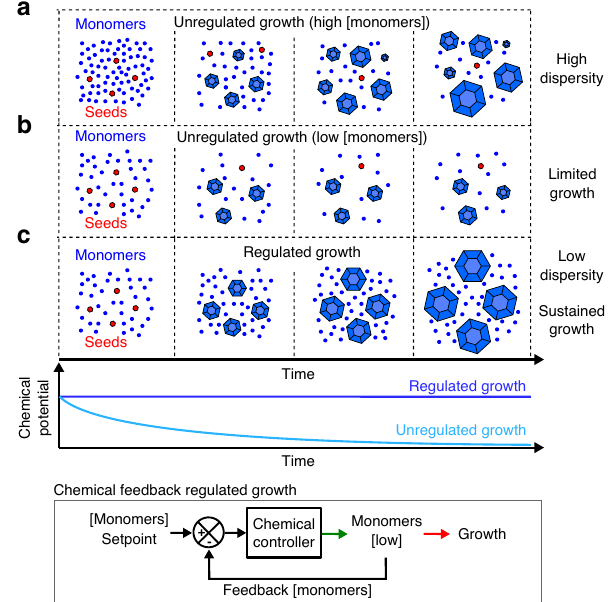
Fig. 1 Crystal size, size dispersity, and quality are shaped by growth conditions, such as the initial monomer concentration and how fast monomers are depleted during crystallization. Schematics show 3D crystals (blue) growing in the presence of seeds (red). a Far above the critical monomer concentration, new crystals homogeneously nucleate (i.e., not from seeds) continuously while other crystals grow. As a result, the crystals that form exhibit high size dispersity. Under these conditions, monomer addition to crystals is strongly forward biased, which means that crystals retain defects that form during growth. b When crystals are grown at a monomer concentration just above the critical monomer concentration, no homogenous nucleation occurs and crystals grow uniformly from seeds. However, crystals remain small because the monomer concentration rapidly reaches the critical concentration, halting growth. c When monomer concentration is regulated by a chemical feedback loop that holds the monomer concentration just above the critical concentration even as monomers are depleted by crystal growth, sustained growth of large, uniformly disperse crystals can be